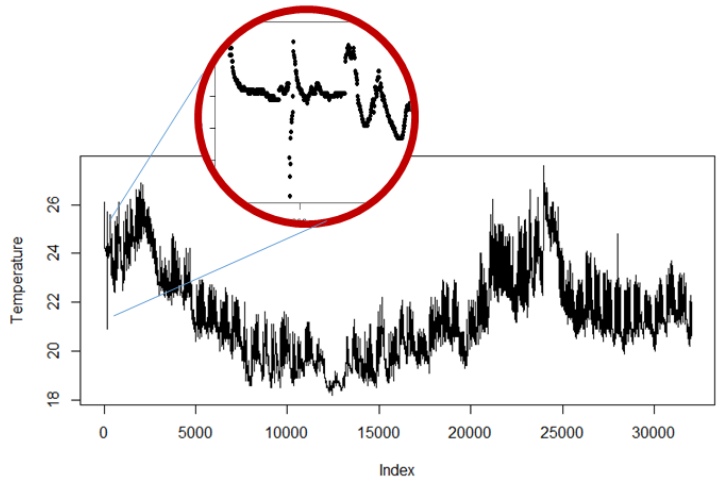
Figure 5. A 1.5 year-long temperature signal containing a couple of abnormal